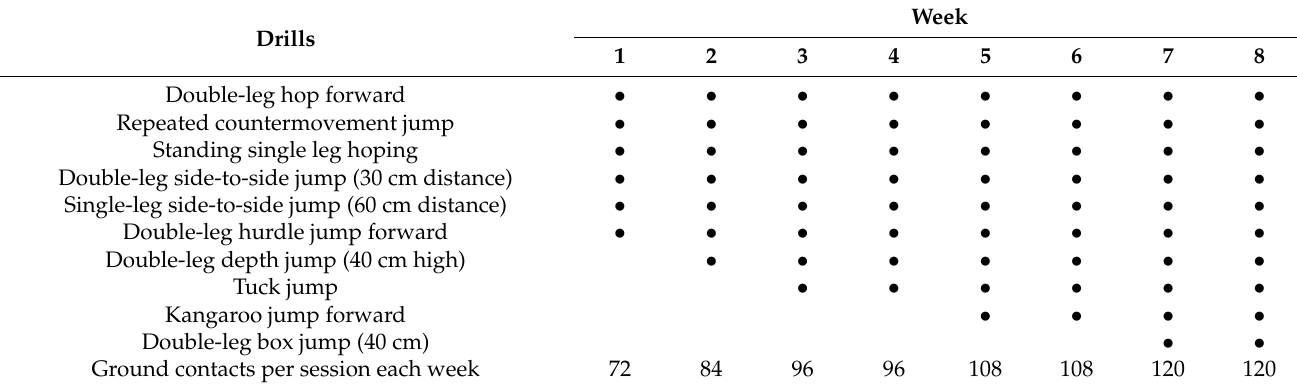
Table 2. Plyometric jump training